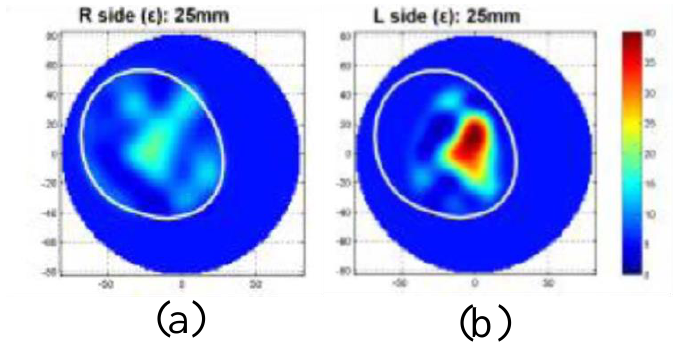
Figure 15. Reconstructed MT images obtained using the system developed by Jeon et al. [70]. ( a ) An image of the right tumour-free breast. ( b ) An image of the left breast, which indicates the presence of a 25 mm tumour. Reprinted with permission from